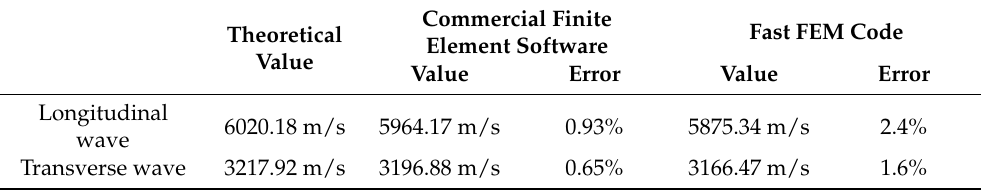
Figure 8. Comparison of the numerical simulation calculation and storage between the fast finite element program and commercial finite element software.